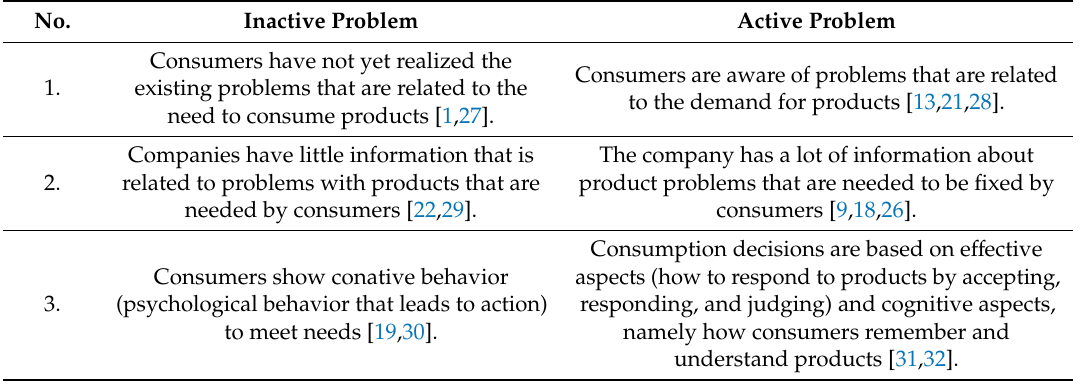
Table 1. Differences between inactive problems and active problems.